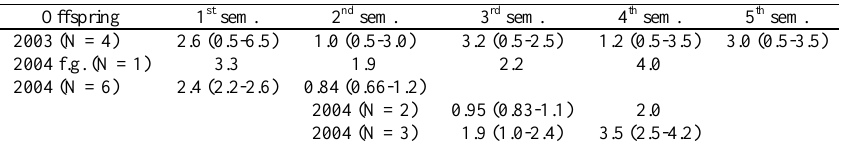
Table 2. Mean values (and ranges) of growth rates (in mm) for the first semesters of life of Ancistrus cryptophthalmus individuals born in laboratory. The rates relative to the individuals born in 2004 (2004 offspring) are shown separately: for all semesters, the single fast growing (f.g.) specimen was separated from the other six; for the third and fourth semesters of life, the remaining group (one fish died) was separated in two.